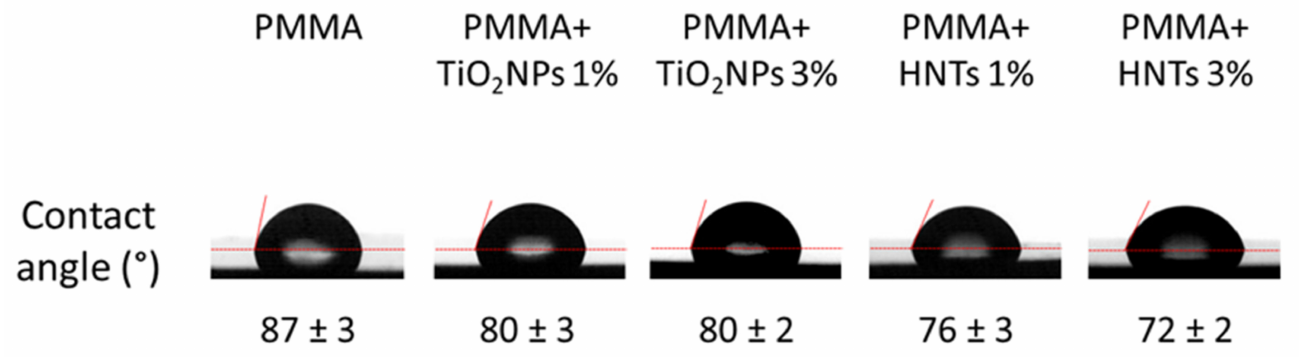
Figure 6. Water contact angle measurements. Representative images of water droplets on different PMMA-based materials and the correspondent contact angle values, obtained as mean on different 10 experiments ±